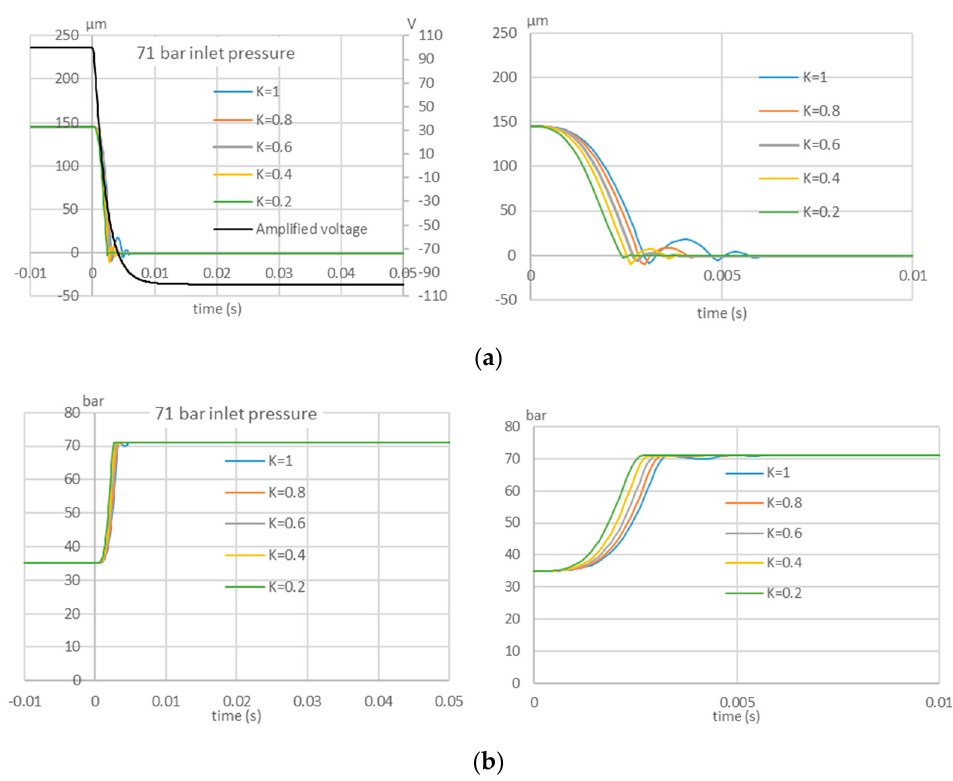
Figure 14. Ring bender displacement with enlargement ( a ) and pressure at point 7 with enlargement ( b ), simulated for an amplified voltage from − 100 V to +100 V and for different values of the mass of the moving parts: m = K m 0 , with K = 1, 0.8, 0.6, 0.4, 0.2 (supply pressure = 71 bar, D = 0.6 D 0 and L = 0.6 L 0 ).